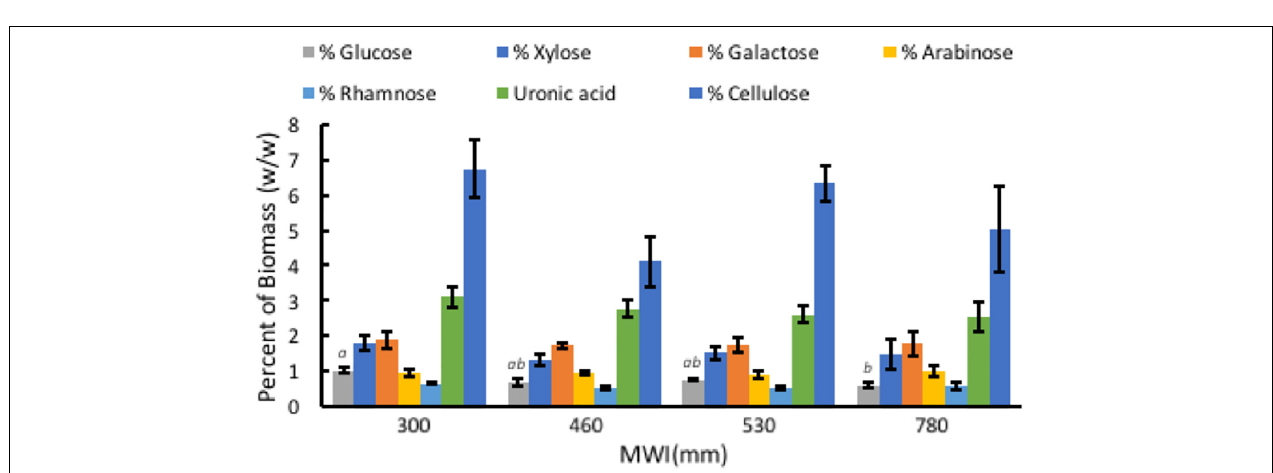
FIGURE 5 | Relationships associated with MWI (mm y − 1 ) and polysaccharide composition in dry biomass (%) from TFA hydrolysis and phenol-sulfuric acid hydrolysis of EFBM showing percent glucose, xylose, galactose, arabinose, rhamnose, uronic acid, and cellulose for A. americana . Error bars indicate standard error of the mean; n = 4. Lowercase letters above bars indicate significant differences in glucose ( p < 0.05) from one-way ANOVA and Tukey’s HSD test. No significant difference in the other sugars were observed between species ( p >